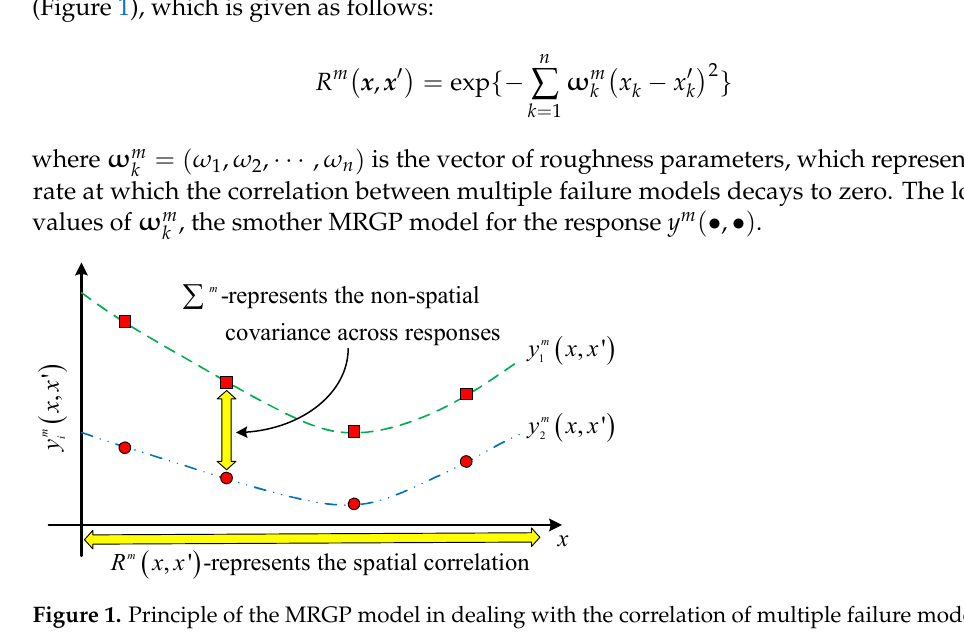
Figure 1. Principle of the MRGP model in dealing with the correlation of multiple failure modes.